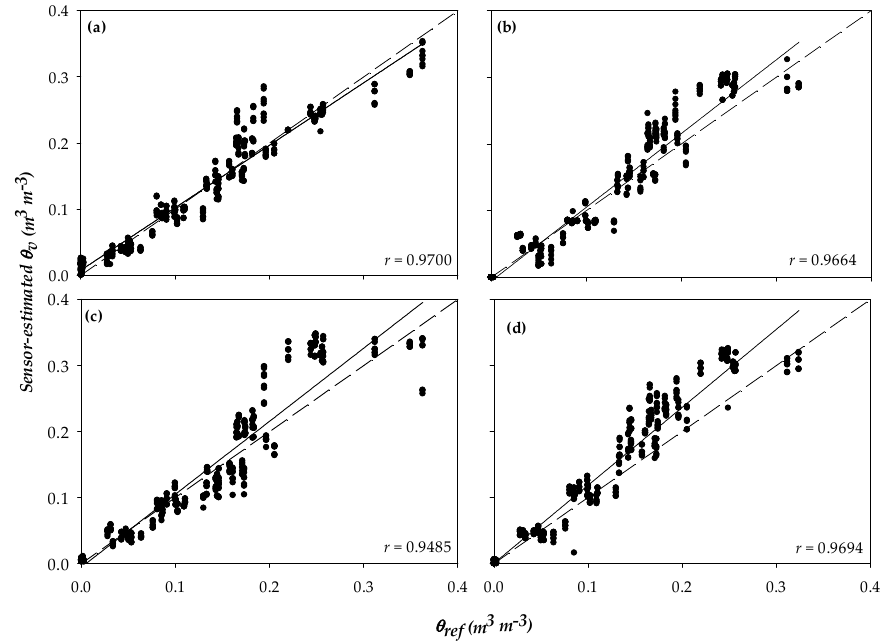
Figure 5. Pearson correlation coe ffi cient ( r ) between θ v measured by sensors using the generic equation provided by the manufacturer and determined by gravimetry ( θ ref ) for the Acclima sensors TDR315 ( a ), TDR310S ( b ), TDT-ACC-SEN-SDI ( c ), and TDR315L ( d ). The solid line is the fitted Pearson’s correlation, and the dashed line is the 1:1 reference. Each point represents a single data value taken from each of the three replications by soil series, soil depths, amount of water added, and evaluated sensors ( n =